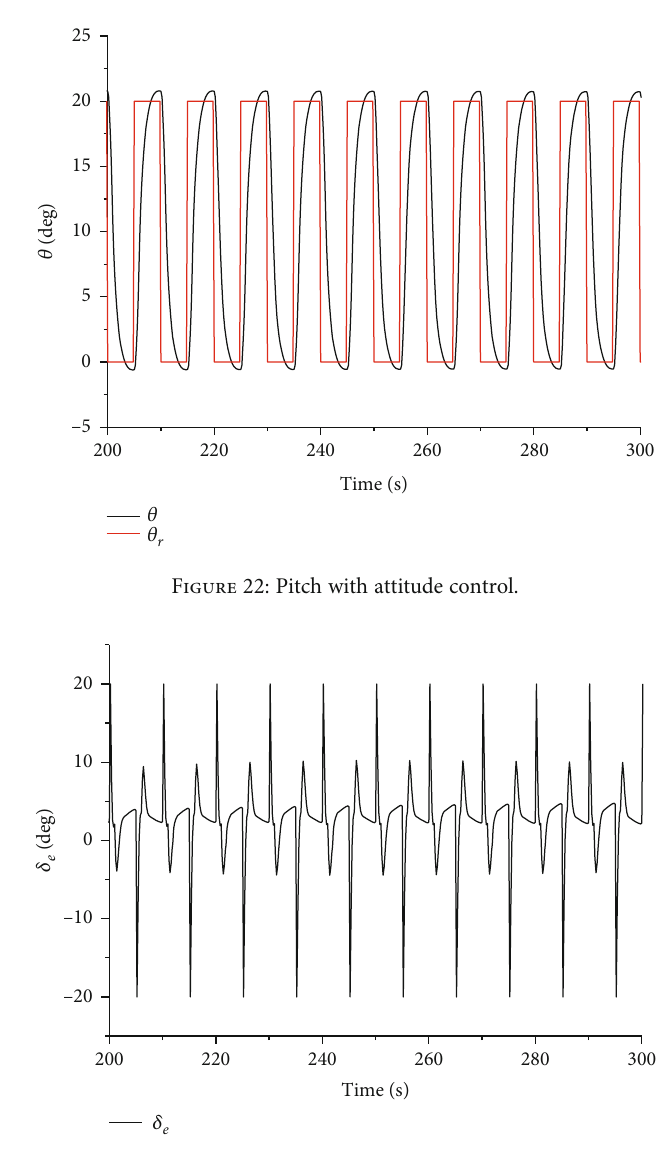
Figure 23: Elevator with attitude